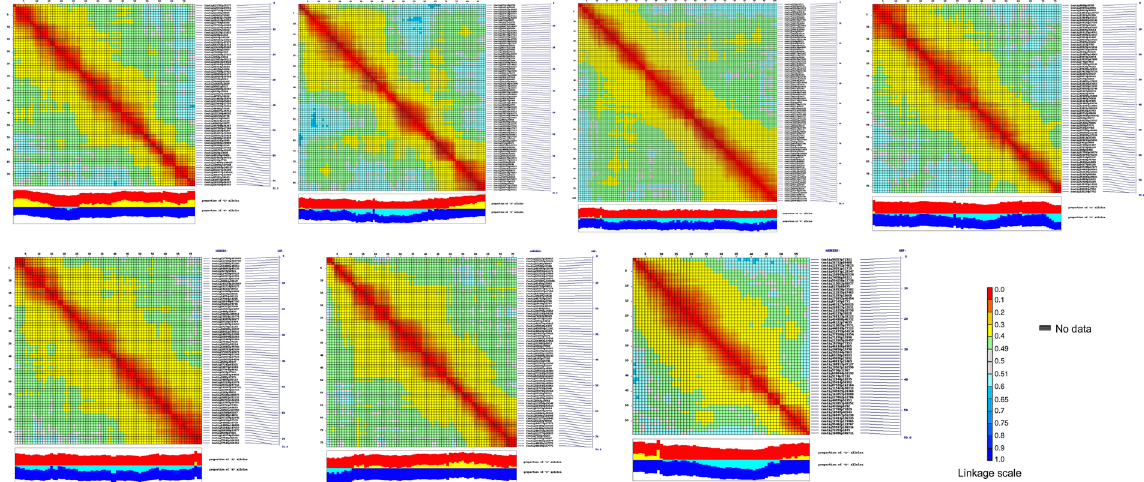
Figure 4. Validation of the genetic linkage map of Lens ervoides recombinant inbred line population LR-66. 2D-CheckMatrix heat plots were generated using the CheckMatrix python script. Each heat plot represents a linkage group. SNP markers are lined up against each other. A red block along the lines indicates tightly linked markers with low recombination. Panels beneath heat maps show the proportion of parental alleles (Red = L01- 827A, Blue = IG 72815). Yellow (L01-827A) and light blue (IG 72815) colors in the middle represent segregation